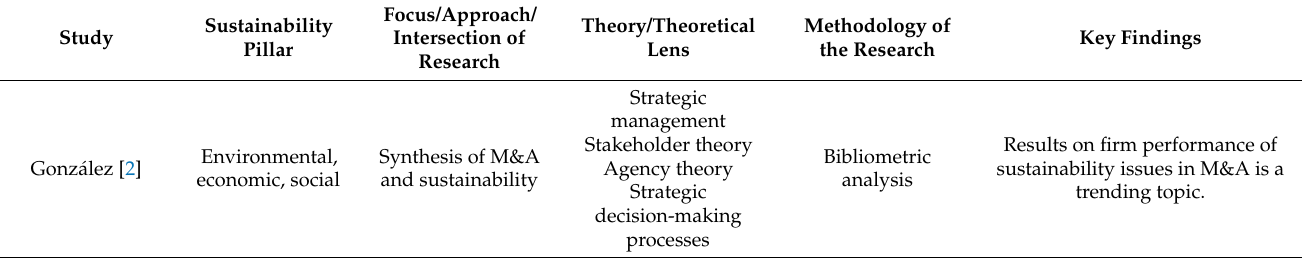
Table A1. Results of systematic literature review and SALSA